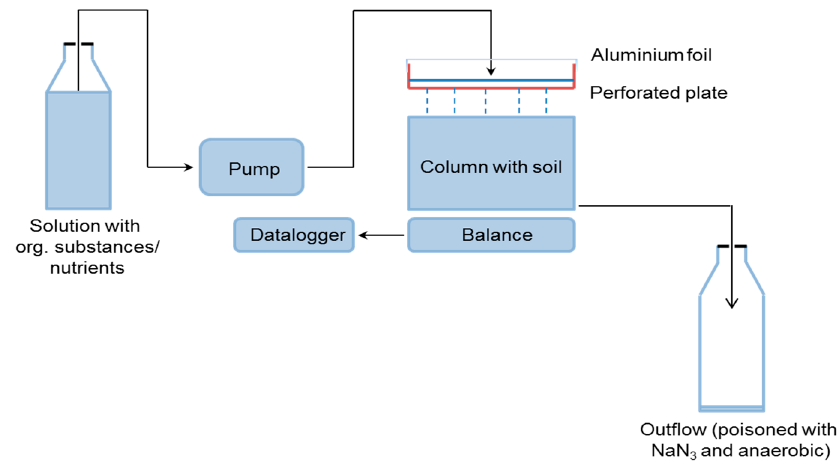
Figure 1. Experimental set-up.